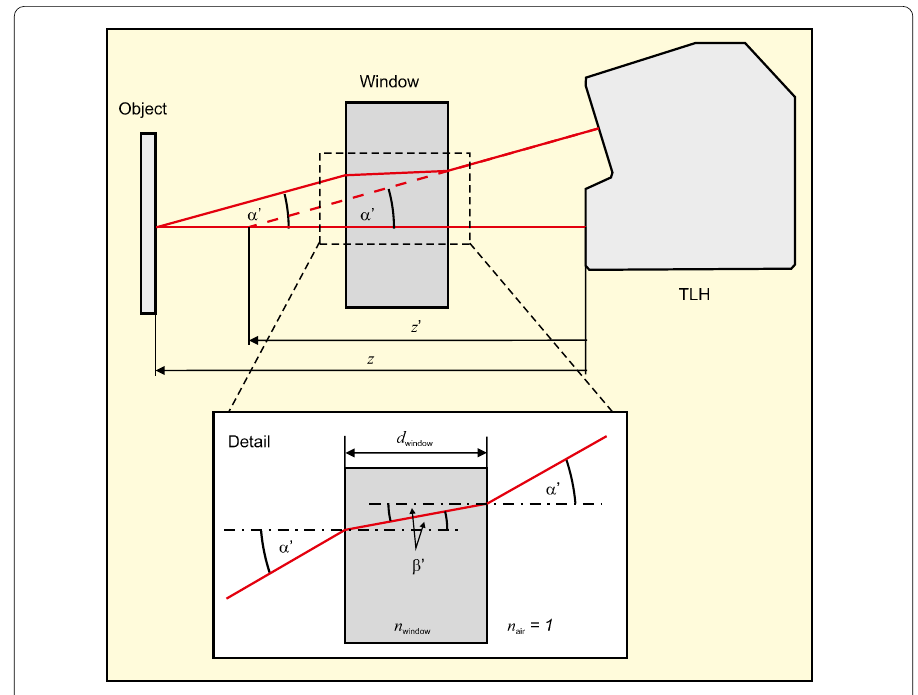
Figure 3 Illustration of the impact of a window on TLH measurement results (window effect): Due to refraction, the object appears to be closer than it